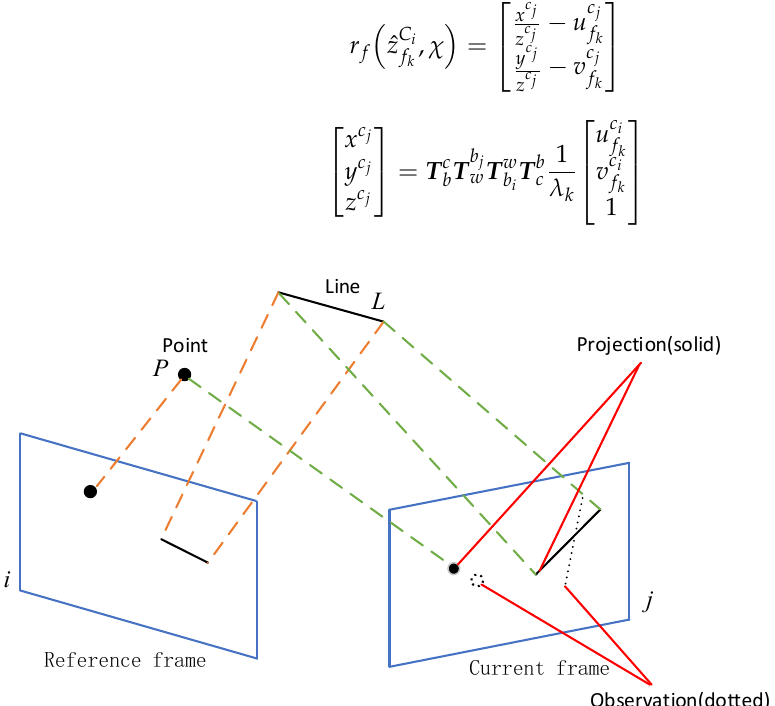
Figure 4. Reprojection error of point and line